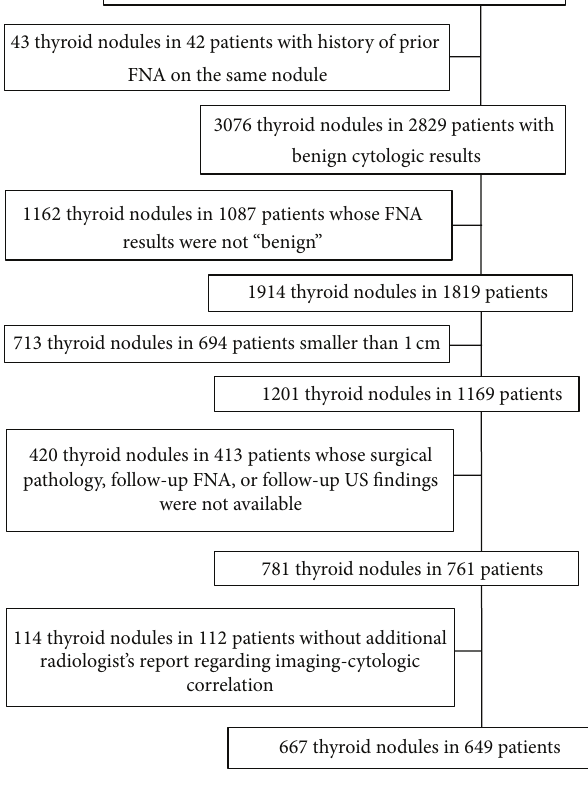
Figure 1: Flow chart of case